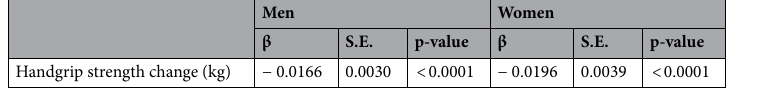
Table 3. Results of the generalized estimating equation analysis of handgrip strength change as a continuous variable and short-form Center for Epidemiologic Studies Depression Scale scores. All covariates in Table 2 were included in this analysis. S.E. standard error.